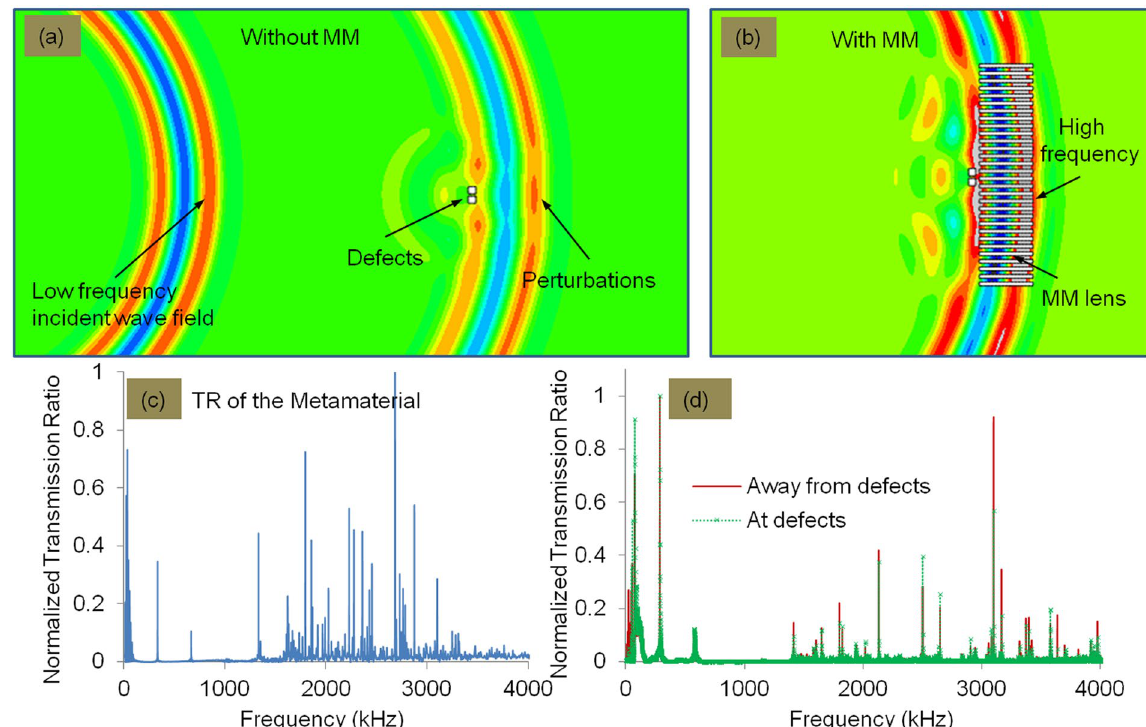
Figure 5. Illustration of wave scattering at defects ( a ) Without and ( b ) With metamaterial lens ( c ) Experimental results showing typical TR of the metamaterial lens ( d ) TR of the metamaterial lens at and away from defect positions. At the defect position several frequency components are suppressed.